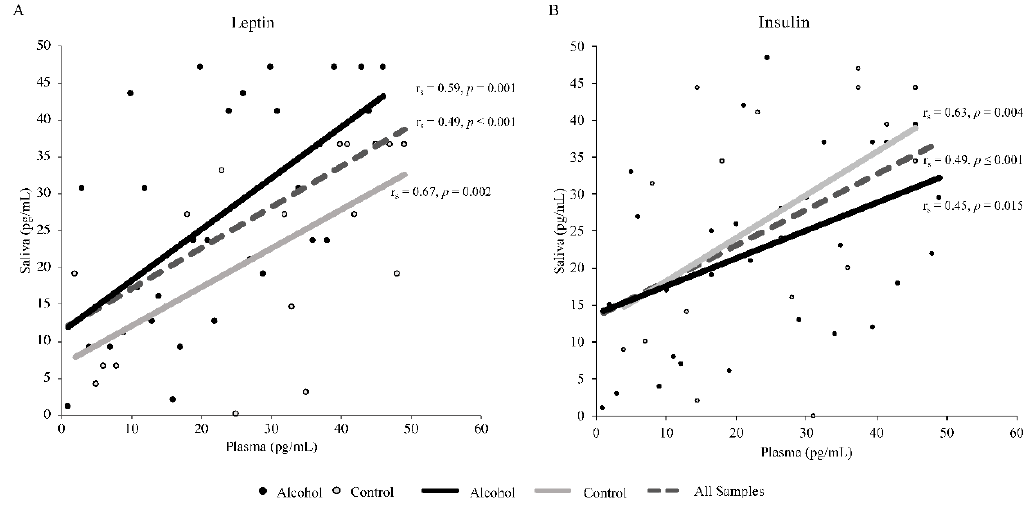
Figure 1. Spearman’s rank correlation between plasma and salivary leptin levels ( A ) and plasma and salivary insulin levels ( B ). The analyses included a total of 49 samples, of which 29 were from the alcohol group and 20 from the control group.